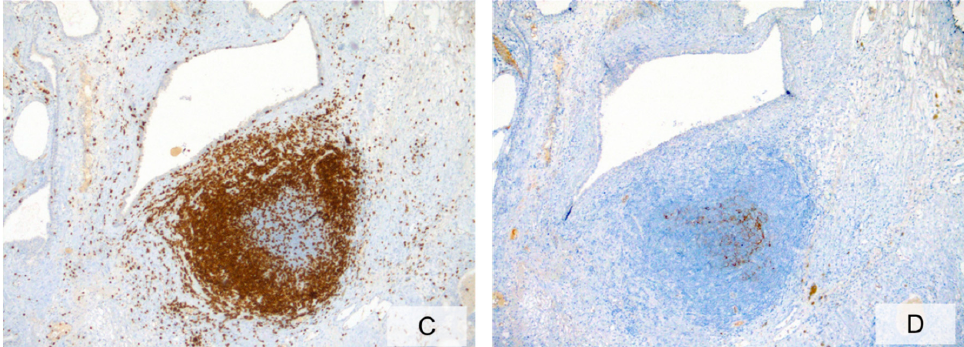
Figure 1. Prostatic stroma showing marked focal chronic inflammation with lymphoid follicle formation ( A , H&E, × 10, black arrow = lymphoid follicle; white arrow = germinal center; * = prostatic glandular lumina; § = prostatic stroma;). Immunohistochemical staining for anti-CD20 ( B , × 10) and anti-CD3 ( C , × 10) highlights the B-cell and the T-cell compartments, respectively. Anti-CD21 staining ( D , × 10) identifies the follicular dendritic cell meshworks in germinal centers.